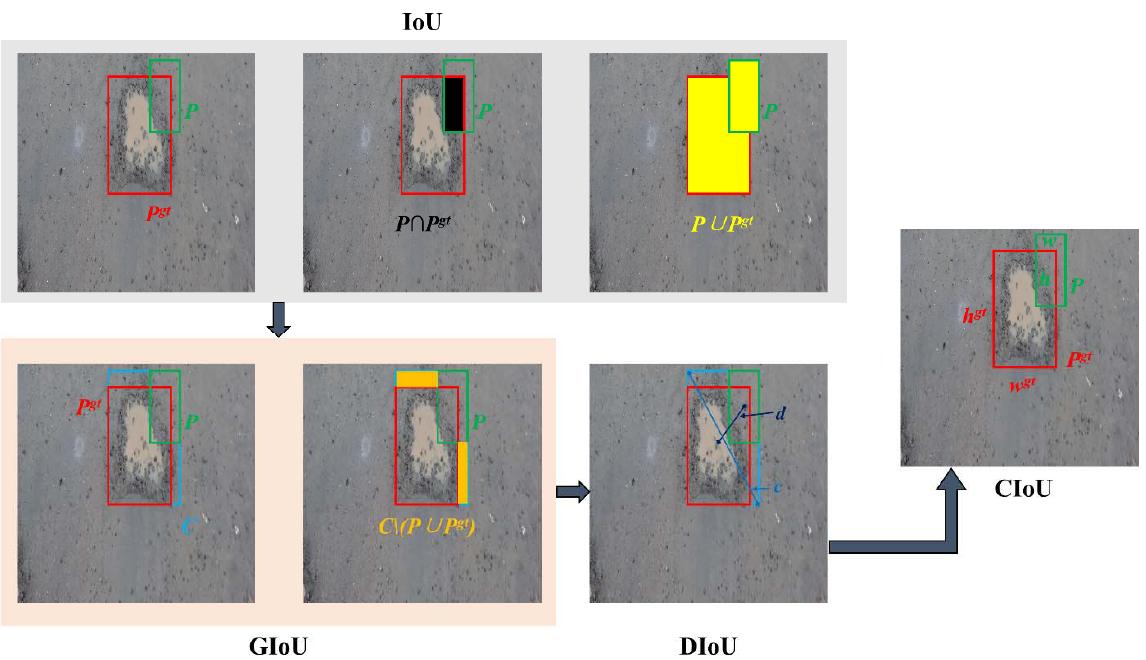
Figure 4. Calculation formula of IoU and its improvement process.